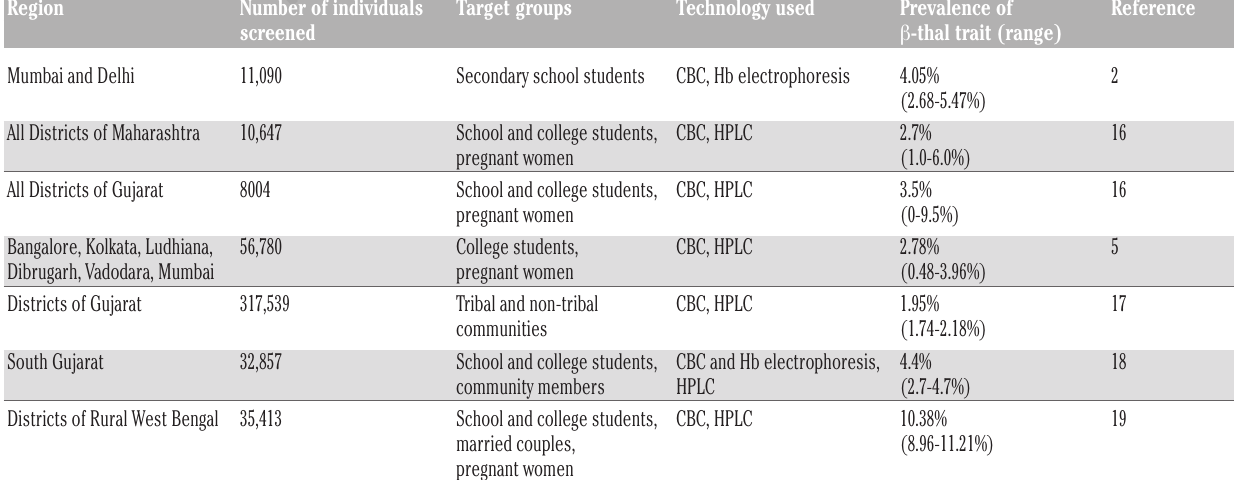
Table 2. Prevalence of b -thalassemia trait reported in large studies.